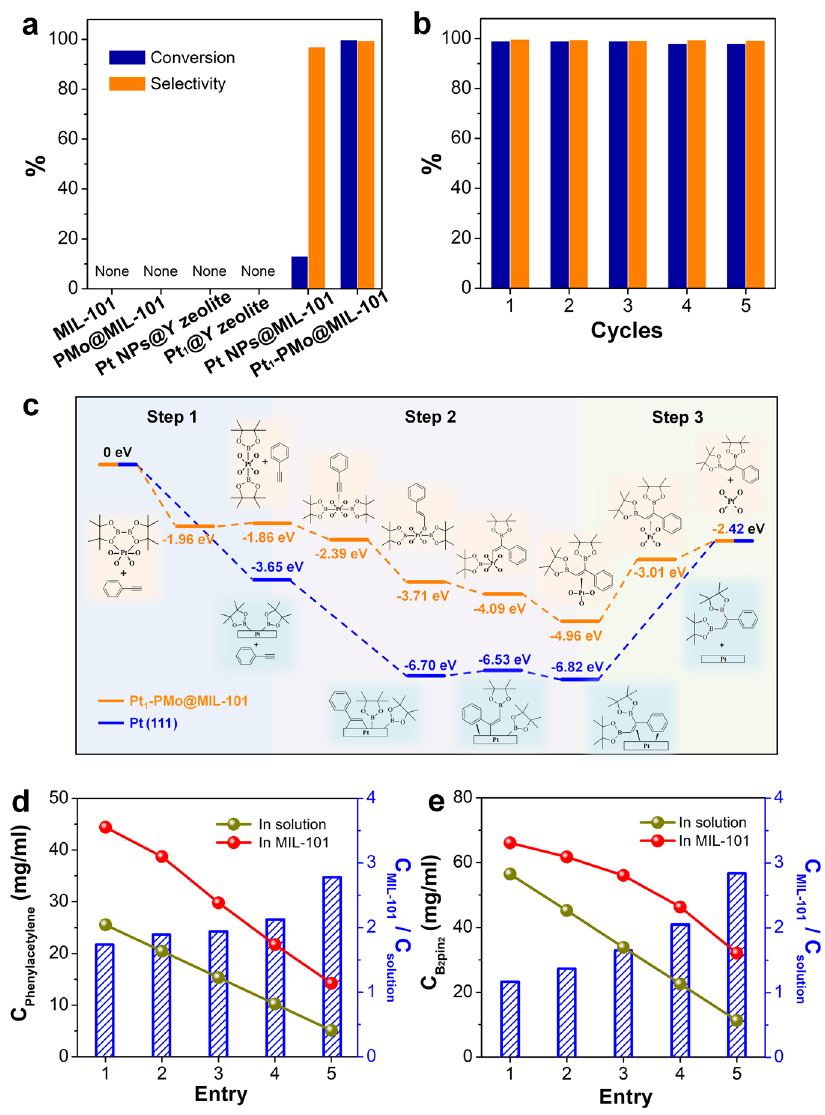
Fig. 4 Catalytic performance, mechanism, and pre-concentration effect. a The catalytic activity of phenylacetylene diboration with different catalysts. b The cyclic catalytic performance of Pt 1 -PMo@MIL-101. Reaction conditions: phenylacetylene (0.5 mmol) and B 2 pin 2 (0.5 mmol), catalyst (20 mg), toluene (2 mL) as solvent, T = 100°C. Conversion is determined by GC analysis with dodecane as the internal standard. Selectivity is determined by GC-MS analysis. c The calculated energy evolution of Pt 1 -PMo@MIL-101 and Pt (111) catalyzed diboration reactions. d , e The pre-concentration effect of MIL-101 for phenylacetylene and B 2 pin 2 . The concentration and corresponding concentration ratio of phenylacetylene ( d ) and B 2 pin 2 ( e ) in MIL-101 and reaction